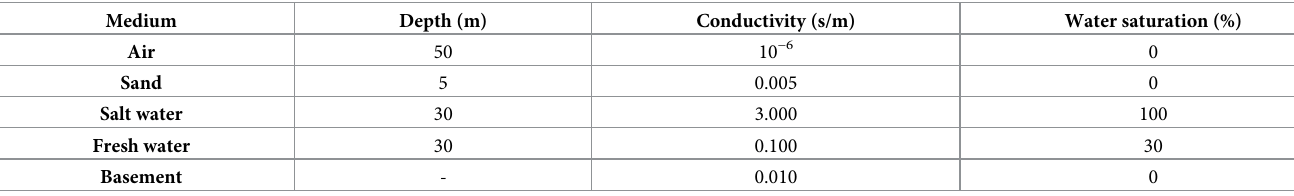
Table 3. The geometric and physical parameters of the marine-sediment model.